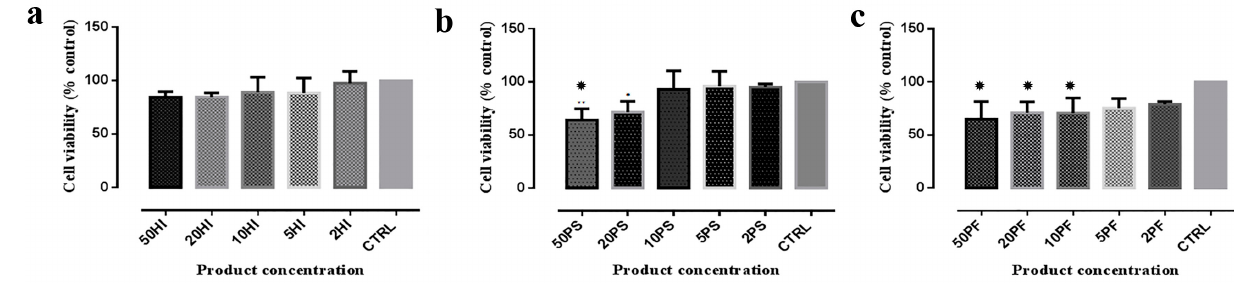
Figure 3. Graphical representation of MTT test. The whiskers correspond to the standard deviation. Results for experimental media containing: ( a ) HI; ( b ) PS; ( c ) PF; HI = HybenX; PS = Perisolv; PF = Perioflush; CTRL = Control. * = statistically different vs. controls.